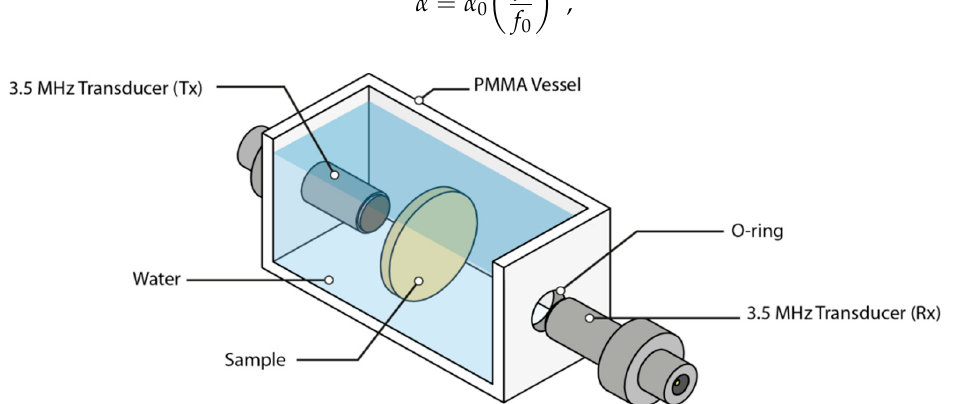
Figure 3. Ultrasonic water-immersion through-transmission layout.